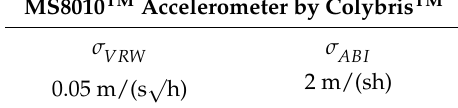
and accelerometer bias instability σ VRW